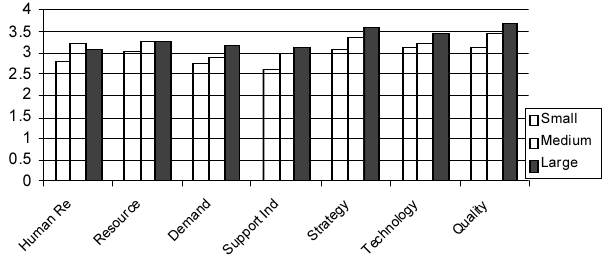
Figure 5: Competitiveness and firm